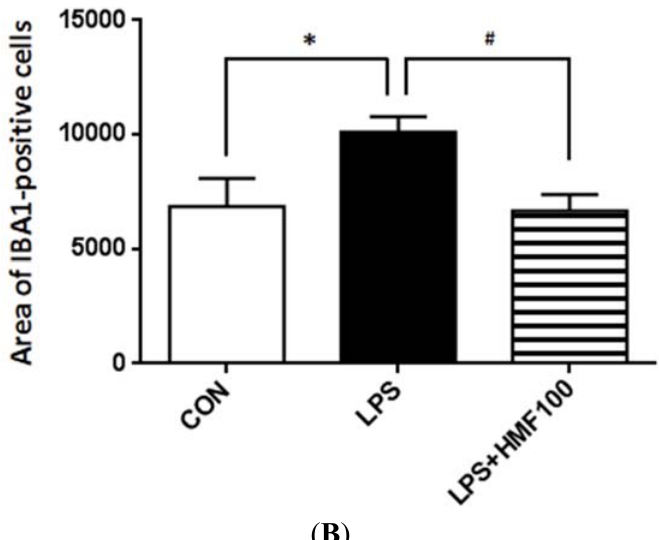
Figure 3. Effects of HMF on the expression of microglia (IBA1) in the mouse hippocampus. The location of the captured images and quantification are shown with squares in the figure. ( A ) Sagittal sections of the hippocampus two days after the LPS intrahippocampal injection stained with an anti-IBA1 antibody; CON, LPS, LPS + HMF100. The scale bar shows 50 µm; ( B ) Quantitative analysis using Image J software of the total areas (pixels) of IBA1-positive cells in the hippocampus. Values are the means ± SEM. Symbols are significantly different for the following conditions: CON vs . LPS, * p < 0.05; LPS vs . LPS + HMF100, # p <